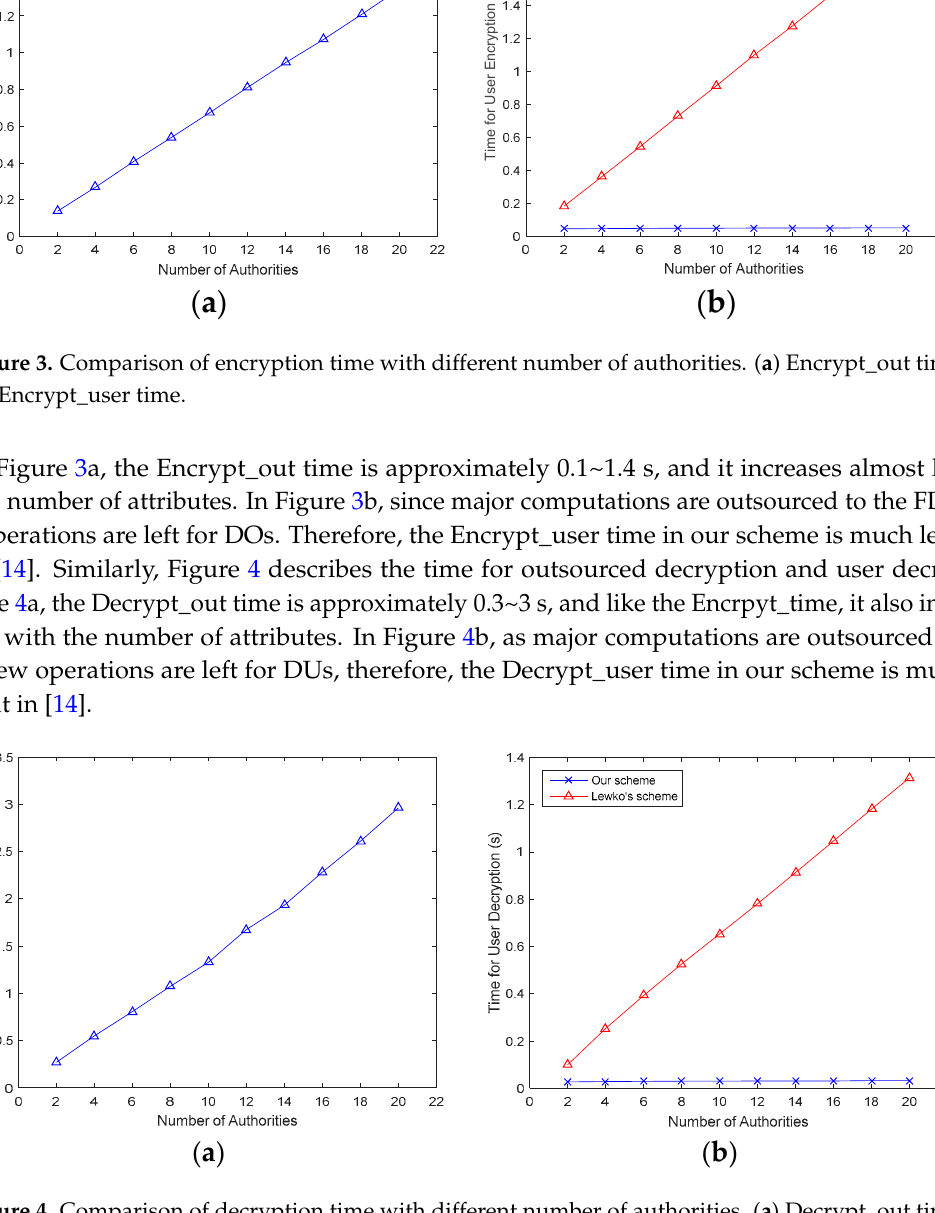
Figure 5. Computing cost for verification of outsourced encryption.